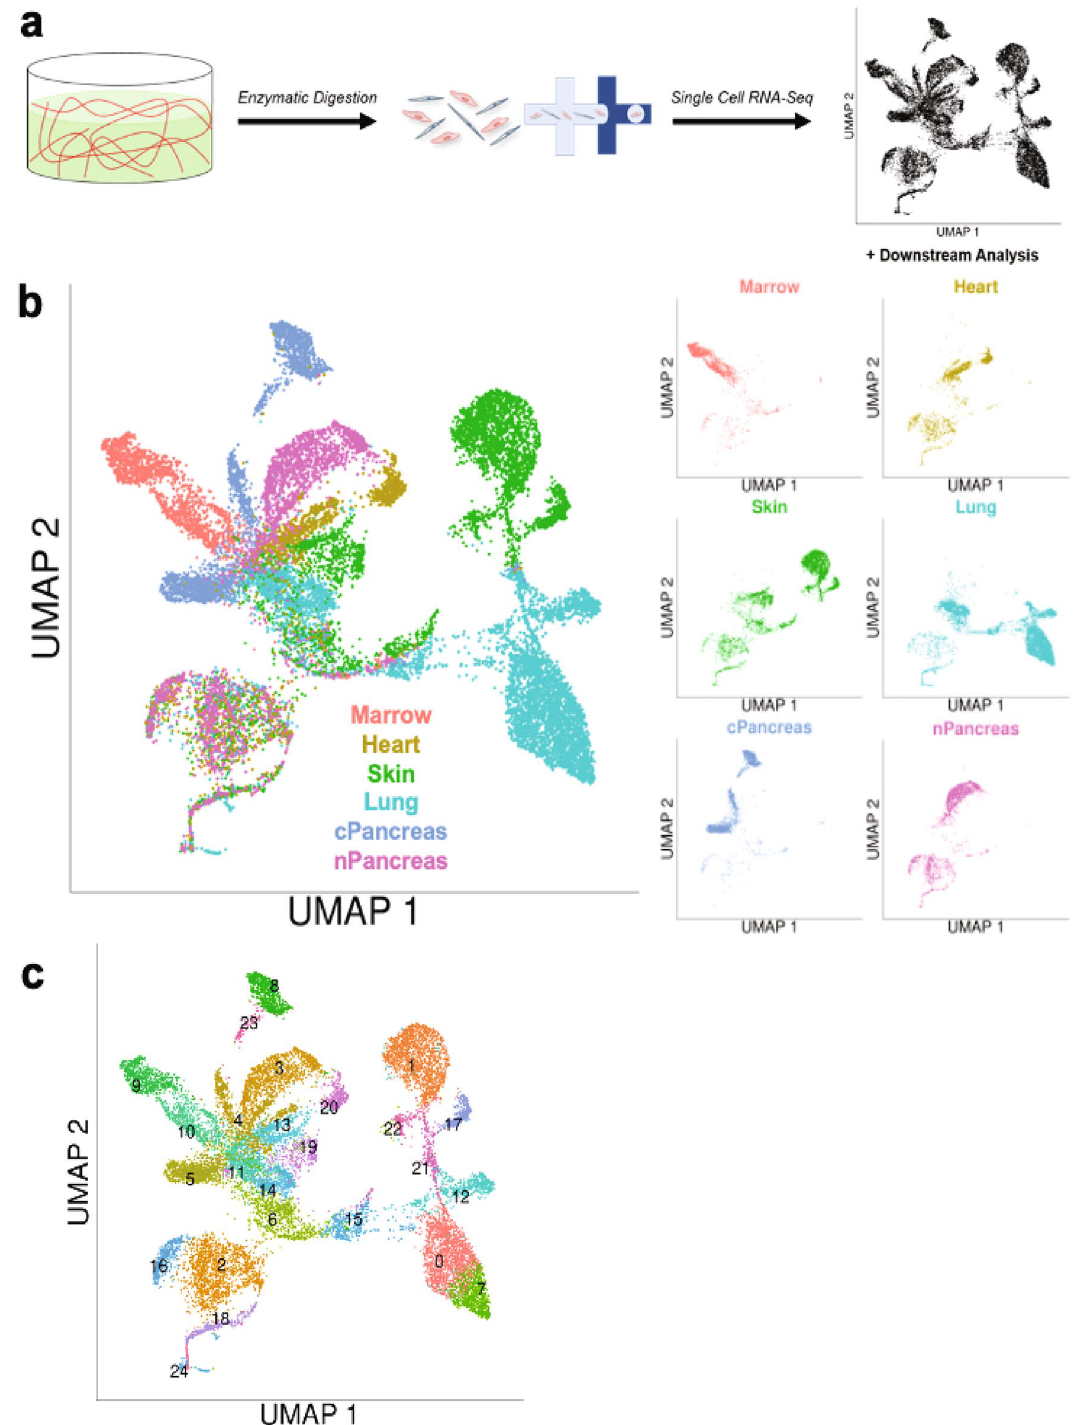
Figure 2. Cells isolated from 3D in vitro fibrin hydrogels can be subjected to scRNA-Seq analysis and are arranged into distinct clusters in UMAP space. ( a ) Schematic detailing processing of 3D in vitro hydrogels for scRNA-Seq. ( b ) Resultant UMAP plots of cells isolated from 3D in vitro fibrin hydrogels comprised of the 6 unique microvessel network types. Additional UMAP plots are broken down by microvessel network type. ( c ) Unsupervised k-means clustering of 3D in vitro hydrogel-derived cells results in 25 distinct